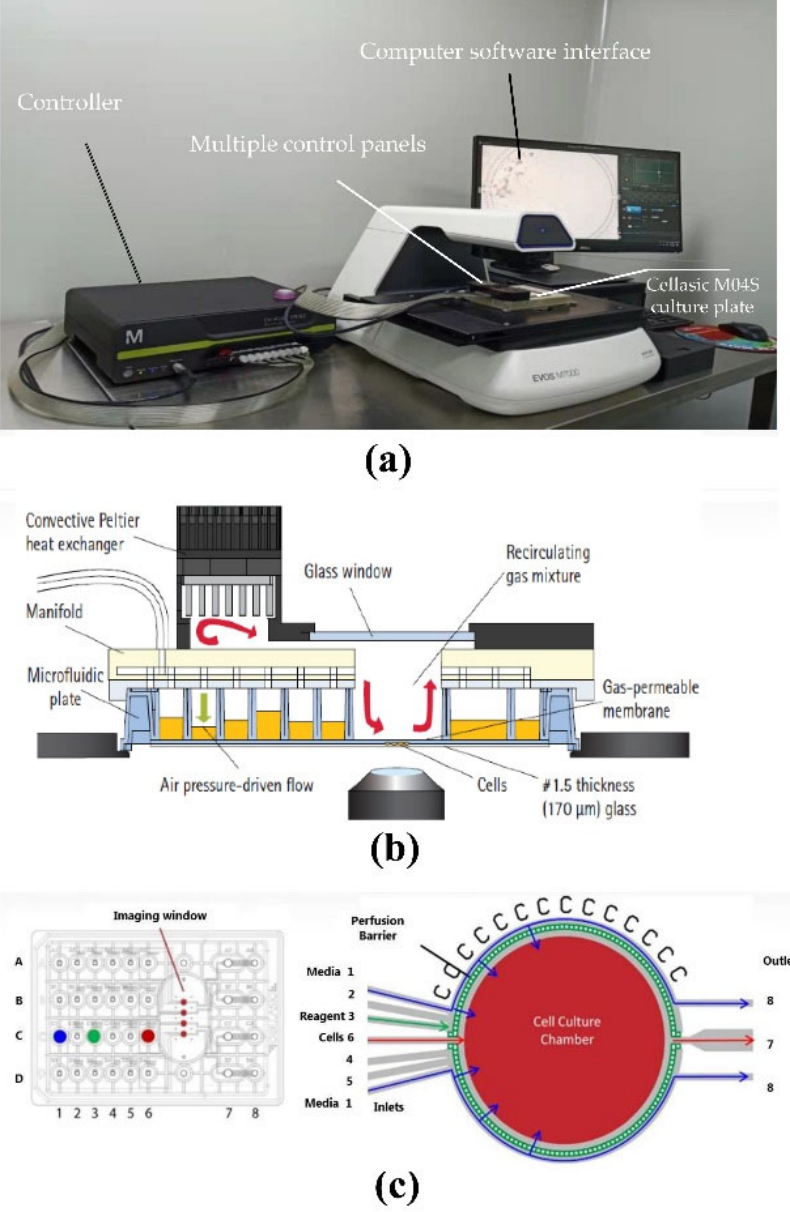
Figure 2. Cellasic microfluidic device dynamic cell culture structure diagram. ( a ) Microfluidic system device. The system includes a computer software interface, controller and multiple control panels. ( b ) View of system in dynamic cell culture microscope; ( c ) Working principle of Cellasic M04S culture